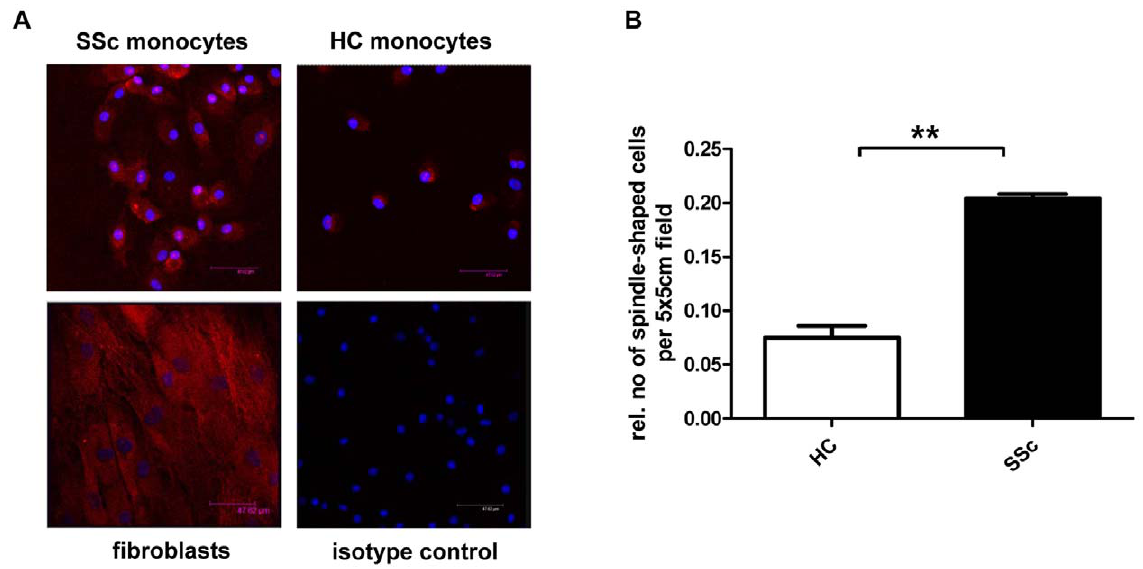
Figure 3. Morphological analysis of monocytes from SSc patients and healthy controls. A) Immunofluorescence staining of a -SMA (red) in GM-CSF treated monocytes from healthy control or a SSc patient. Fibroblasts were used as positive control. Nuclei were stained with DAPI (blue). For quantification, spindle shaped cells per 5 6 5 cm field were counted and normalized to cell numbers (B). ** Statistically highly significant (P-value , 0.01).